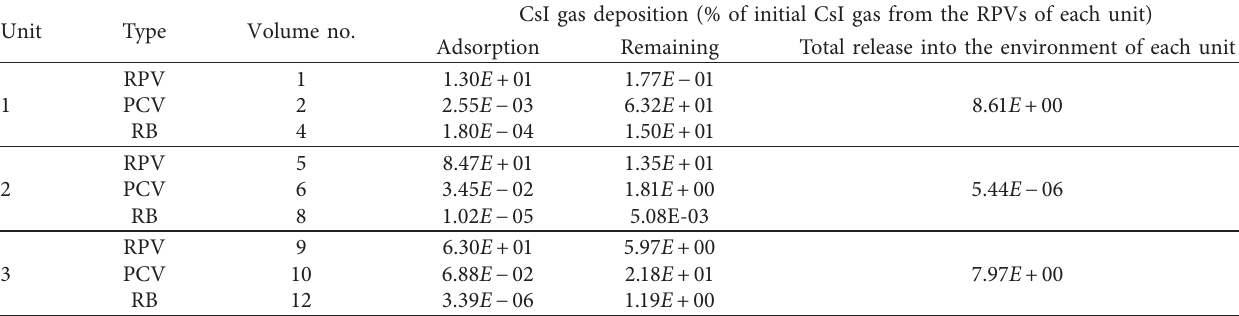
Table 6: Deposition phenomena of CsOH aerosols in Units 1–3 of the first case simulated by Modified ART Mod 2. Unit Type Volume no.